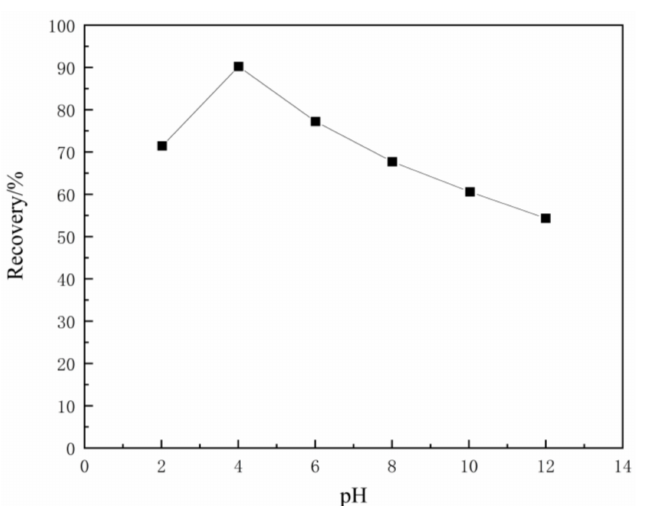
Figure 14. Relationship between the flotation recovery of muscovite and pH (concentration of ODA: 140